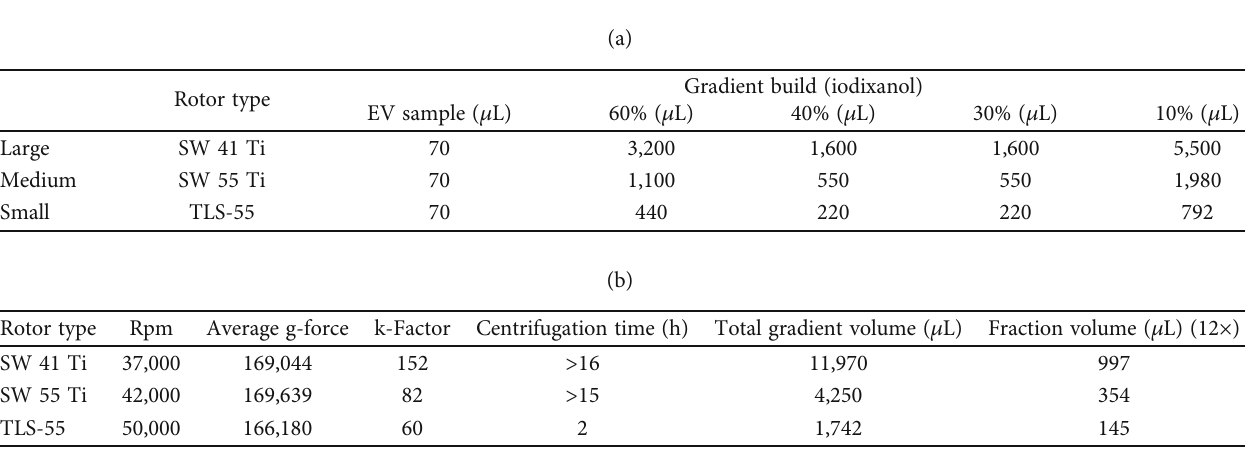
Table 1: Iodixanol gradient volumes and centrifugation